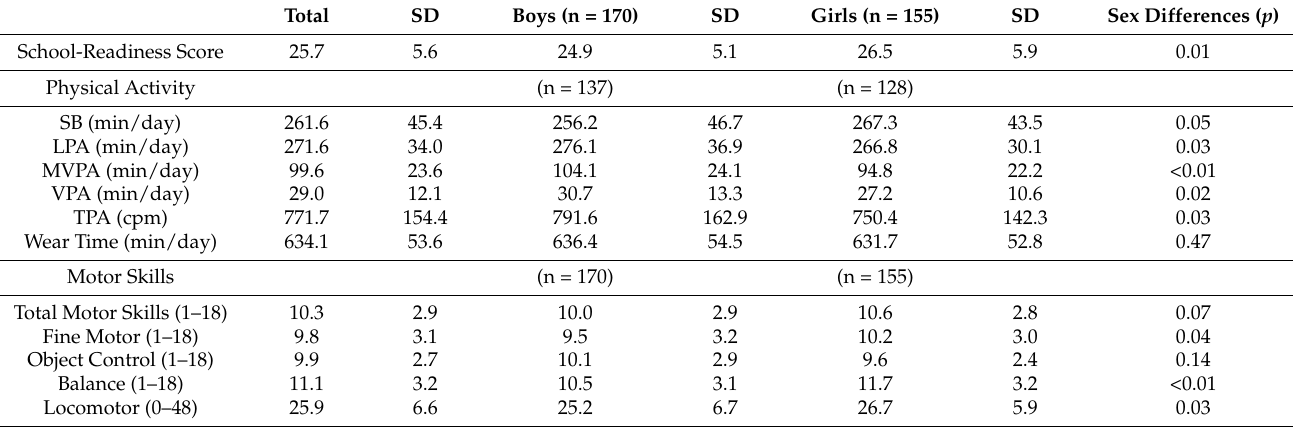
Table 3. Average and sex differences for school-readiness score, activity levels and motor-skill